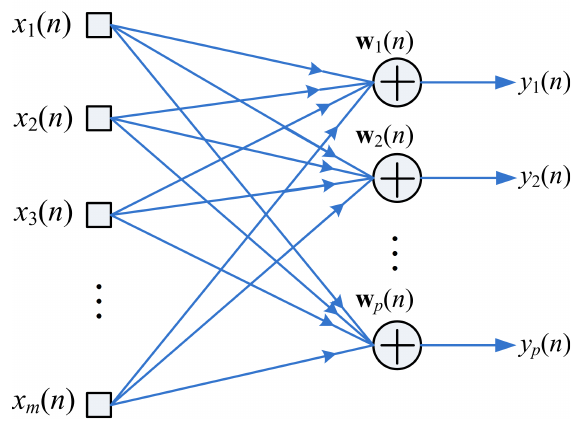
Figure 1. The neural model for the GHA.